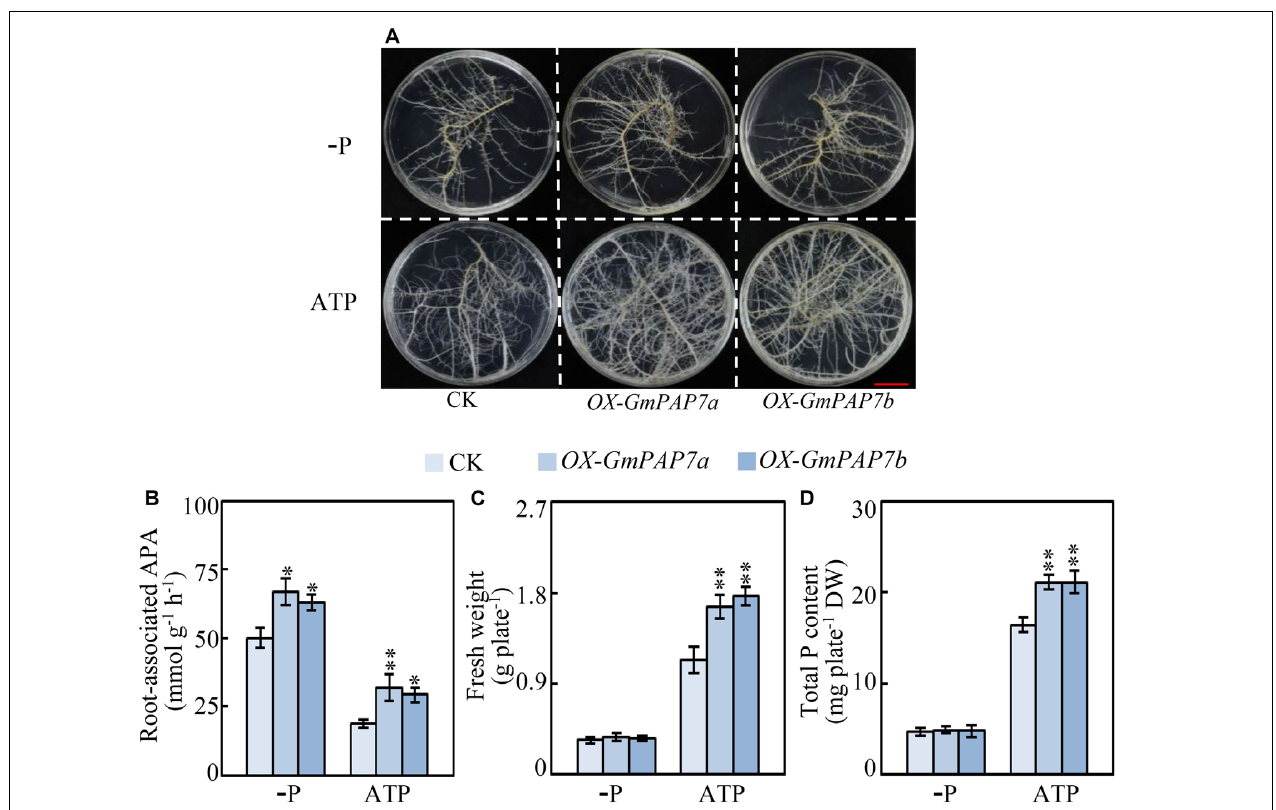
FIGURE 8 | Effects of GmPAP7a and GmPAP7b overexpression on APase activities, total P content and fresh weight of transgenic soybean hairy roots. (A) Image of transgenic hairy roots supplied with different P sources. Bars = 1 cm. (B) Root-associated APase activities. (C) Fresh weight of transgenic soybean hairy roots. (D) Total P content in transgenic soybean hairy roots. Transgenic soybean hairy roots were grown for 14 days on MS media supplemented with 6.25 µ M KH 2 PO 4 (–P) or 0.4 mM ATP as the sole P source. Fresh weight and total P content were separately measured. CK represents transgenic hairy root lines transformed with an empty vector. OX-GmPAP7a and OX-GmPAP7b indicate transgenic hairy root lines overexpressing GmPAP7a and GmPAP7b , respectively. The data are the means of nine replicates with standard errors. The asterisks indicate significant differences between the overexpression and CK lines according to Student’s t -test: ∗ P < 0.05, ∗∗ P <